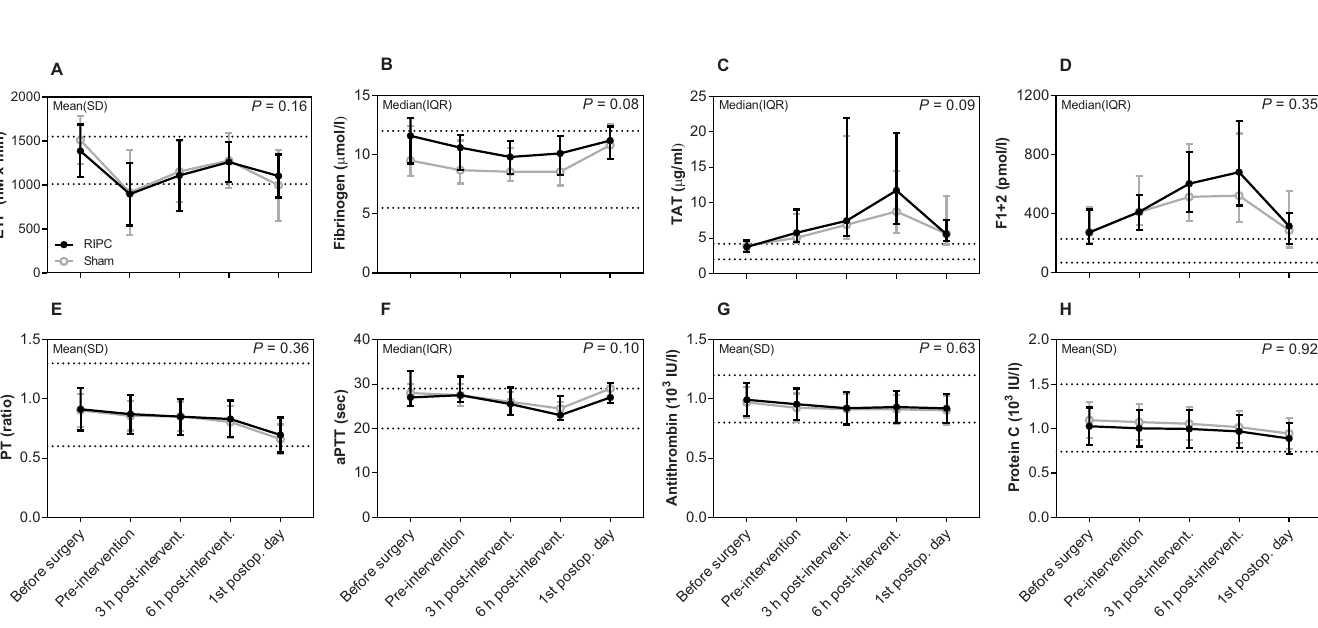
PLOS ONE | https://doi.org/10.1371/journal.pone.0219496 July 8,